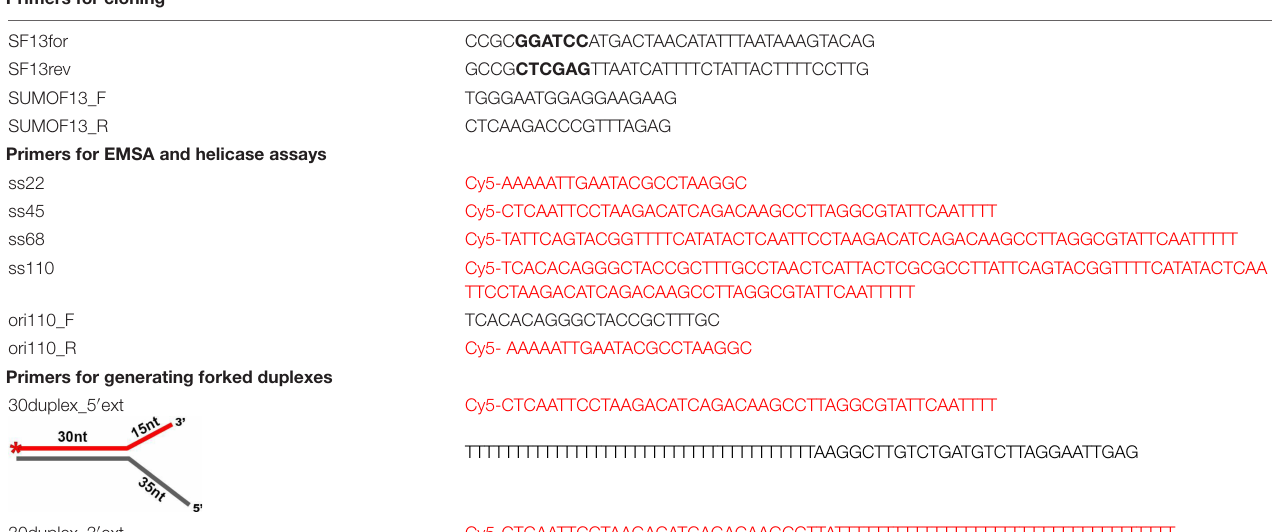
TABLE 1 | Primers used in the study. Primers for